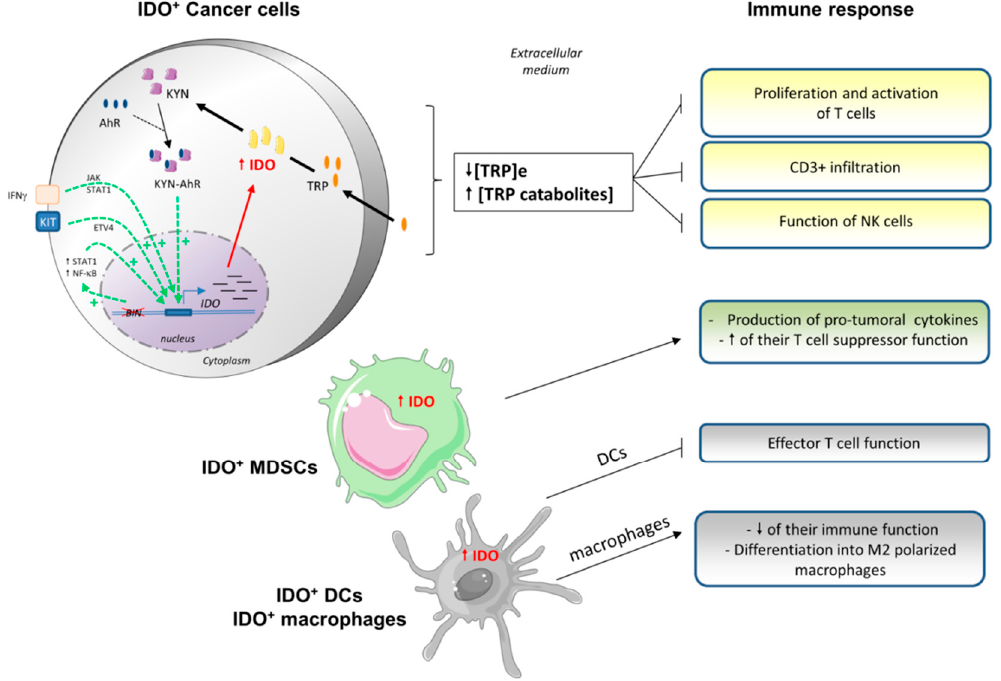
Figure 3. Consequences of indoleamine 2,3 dioxygenase (IDO) overexpression on the antitumoral immune response. Cancer cells frequently overexpress IDO as a result of its transcriptional upregulation. This can be triggered by (i) cytokines such as IFN γ , as long as lymphocytes are present within the tumor, (ii) the oncogene Kit, or (iii) mutations within the tumor suppressor gene Bin. IFN γ promotes IDO overexpression by activating the Janus kinase/signal transducer and activator of transcription (JAK/STAT) pathway, while Kit and Bin stimulate ETV4 (ETS variant 4), and STAT1 and/or nuclear factor (NF)- κ B, respectively. IDO expression levels can also be regulated by an autocrine loop, implying the complex KYN-AhR. Once in the cytosol, IDO mediates the transformation of tryptophan (TRP) into N-formylkynurenine that is then transformed into kynurenine (KYN). IDO overexpression leads to a decrease in the extracellular level of TRP, which limits the action of immune cells: T cells are not proliferating and can’t be activated; and CD3+ cells infiltrate less frequently and the function of NK cells is reduced. Cells other than cancer cells can overexpress IDO, including some immune cells such as MDSCs and DCs/macrophages. The overexpression of IDO in such cells restrains their own immune function (macrophages), suppresses T cells activity (DCs), and induces protumoral cytokines (MDSCs). As a result, in IDO overexpressing tumors, the antitumoral immune response is largely compromised.